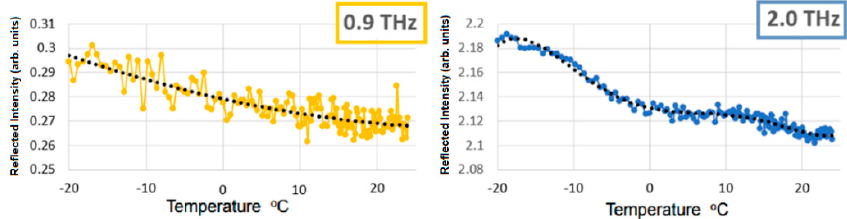
Figure 7. Spectral bands centered around 0.9 and 2.0 THz. There is a decline in reflected signal intensity with increasing temperature at both frequencies with a temperature dependent plateau over the 0 to 10 °C range at 2.0 THz.